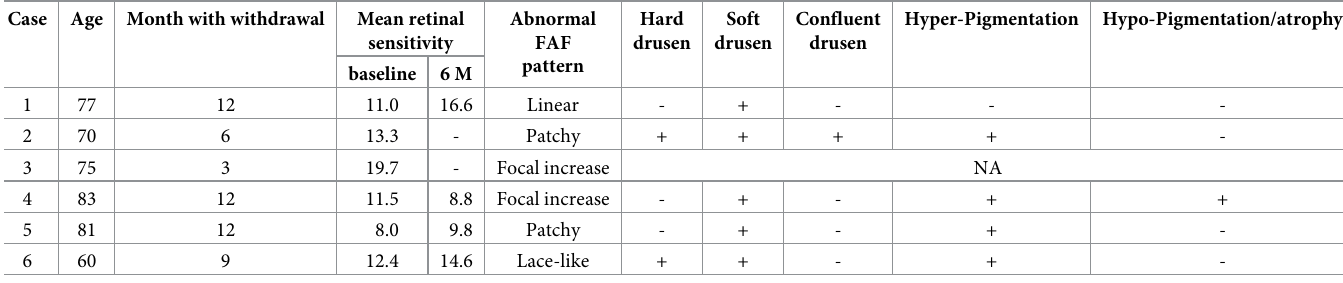
Table 4. Characteristics of six eyes with progression to neovascular